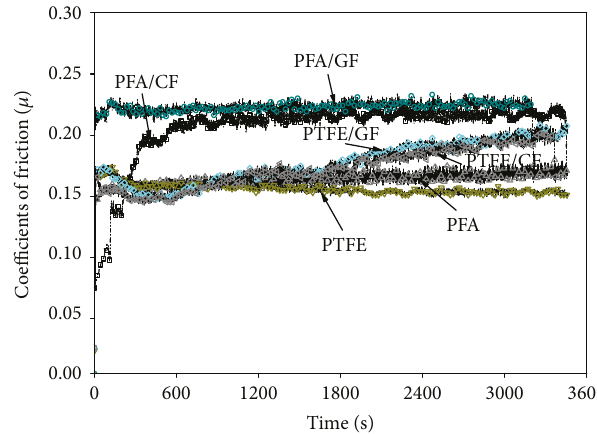
Figure 2: Coe ffi cients of friction variation of the PTFE and PFA composites with respect to